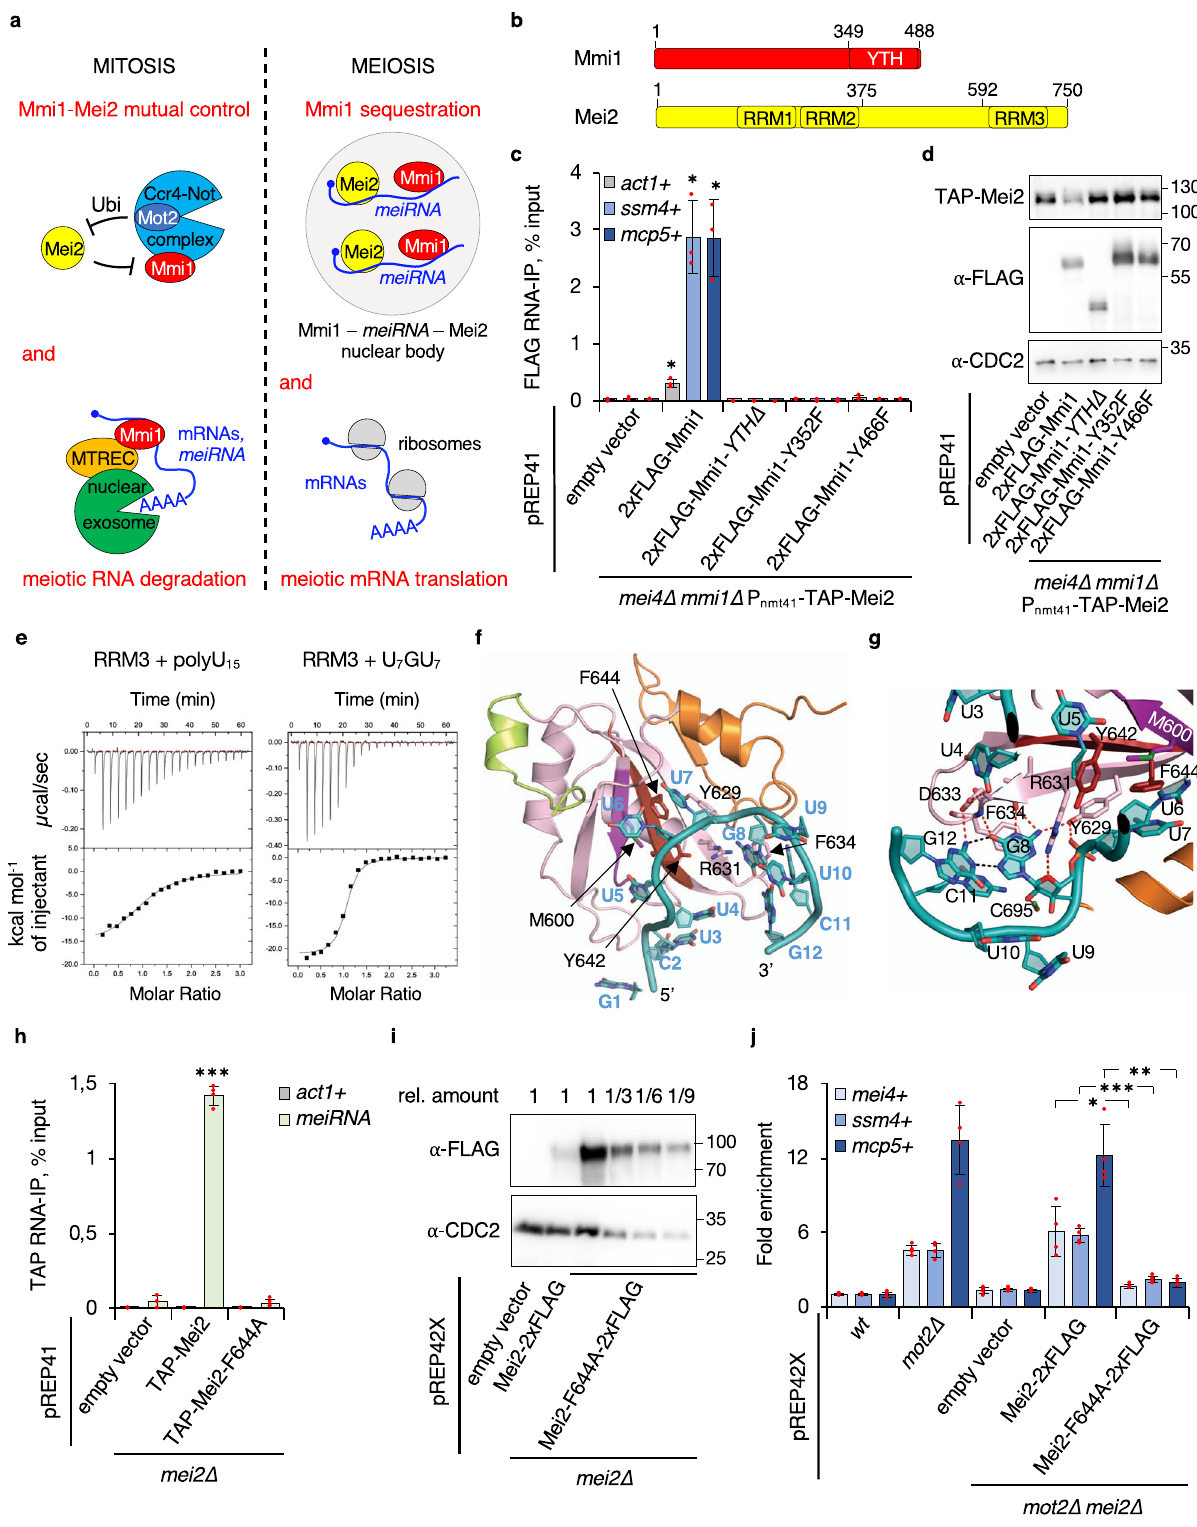
cytosine ring cannot form a hydrogen bond with the amino group from N680 main chain (Supplementary Fig. 1k). U4 binding pocket is solvent exposed and hence any nucleotide may fi t in it. Collectively, our results suggest that RRM3 Mei2 recognizes UU(U/ G/A)G motifs in RNA targets and provide a structural basis